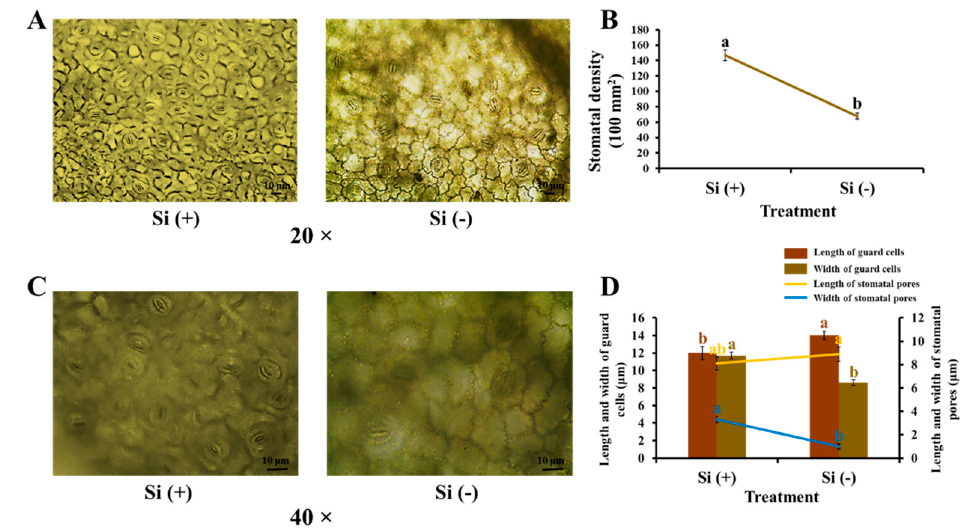
Figure 5. Effect of 30 days of silicon application on stomatal characteristics in the coffee plants grown in plant growth chambers. Stomatal density ( A , B ), 20 times amplification. Stomatal morphology ( C , D ), 40 times amplification. Si (+) and Si (-) refer to 75 and 0 mg·L − 1 , respectively. Vertical bars indicate the means ± standard error ( n = 6). Different lowercase letters indicate the significant separation within treatments by the Duncan’s multiple range test at p ≤ 0.05. Bars indicate 10 μ m.